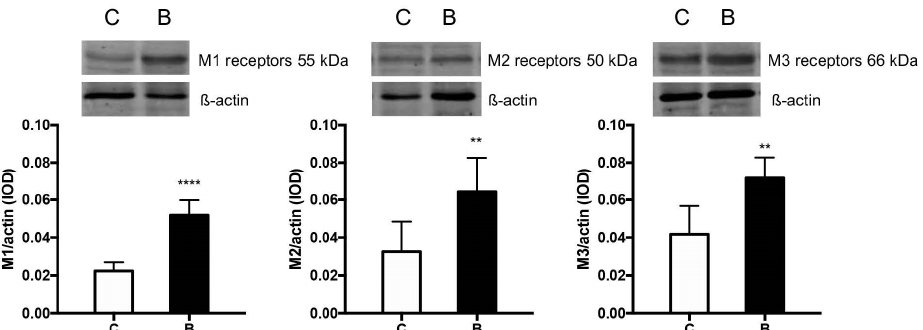
Figure 4. Quantitative results of optical density and representative Western blots of M1, M2, and M3 receptor expression in the lysates from the mucosa of the middle jejunum segments in newborn pigs. Piglets fed milk formula alone (group C) or supplemented with sodium butyrate at a dose of 0.3% (group B). Values are given as means ± SEM; * indicates statistical differences between groups when ** p < 0.01, **** p < 0.0001.